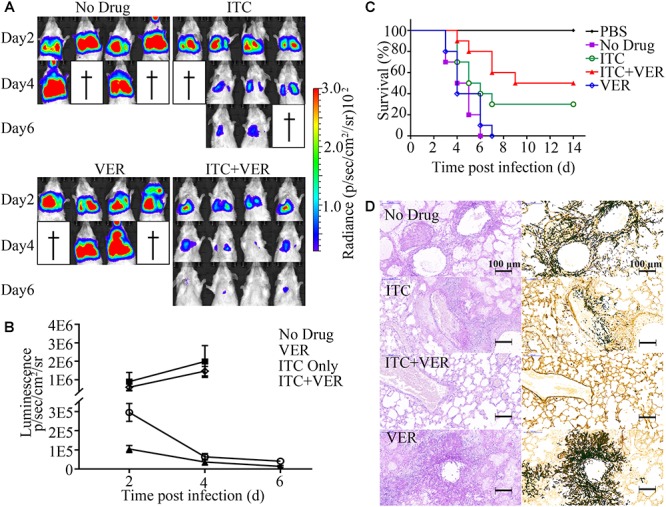
Coadministration of itraconazole and verapamil improves survival rate and reduces lung burden. (A) Luciferase signals from four infected mice each from the groups treated with ITC (20 mg/kg), VER (5 mg/kg) or ITC + VER were measured by live animal imaging. Luciferase activities at days 2, 4, and 6 post-infection are shown. (B) Luminescence acquired from the lung area of each mouse (in A) was analyzed with the software Living Image 4.2. Error bars indicate SD. (C) Ten infected BALB/c mice receiving ITC, VER or ITC + VER treatment were monitored for 14 days. A Kaplan–Meier survival plot is shown. (D) Lung tissues from mice of the No Drug, ITC, ITC + VER, and VER groups were isolated and stained with PAS and silver stain.